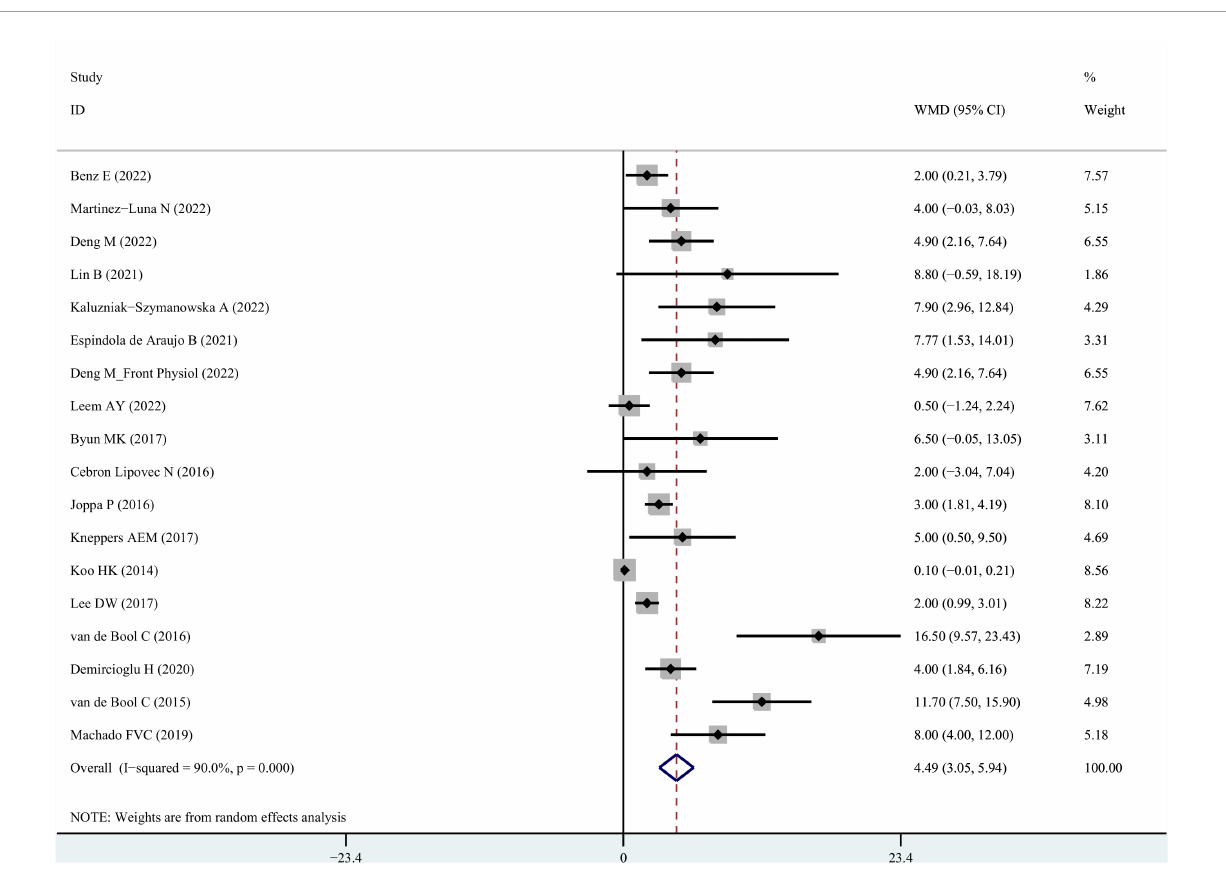
FIGURE4 WMD forest plot and its 95% CI for FEV1/FVC in COPD group and sarcopenia + COPD group. FEV1, forced expiratory volume in 1 s; FVC, forced vital capacity; WMD, weighted mean